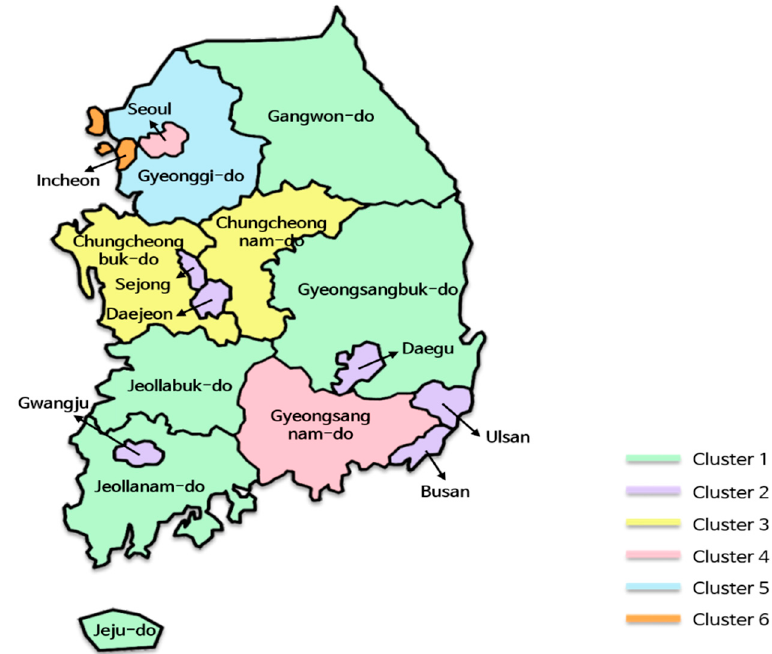
Figure 10. The region clusters.